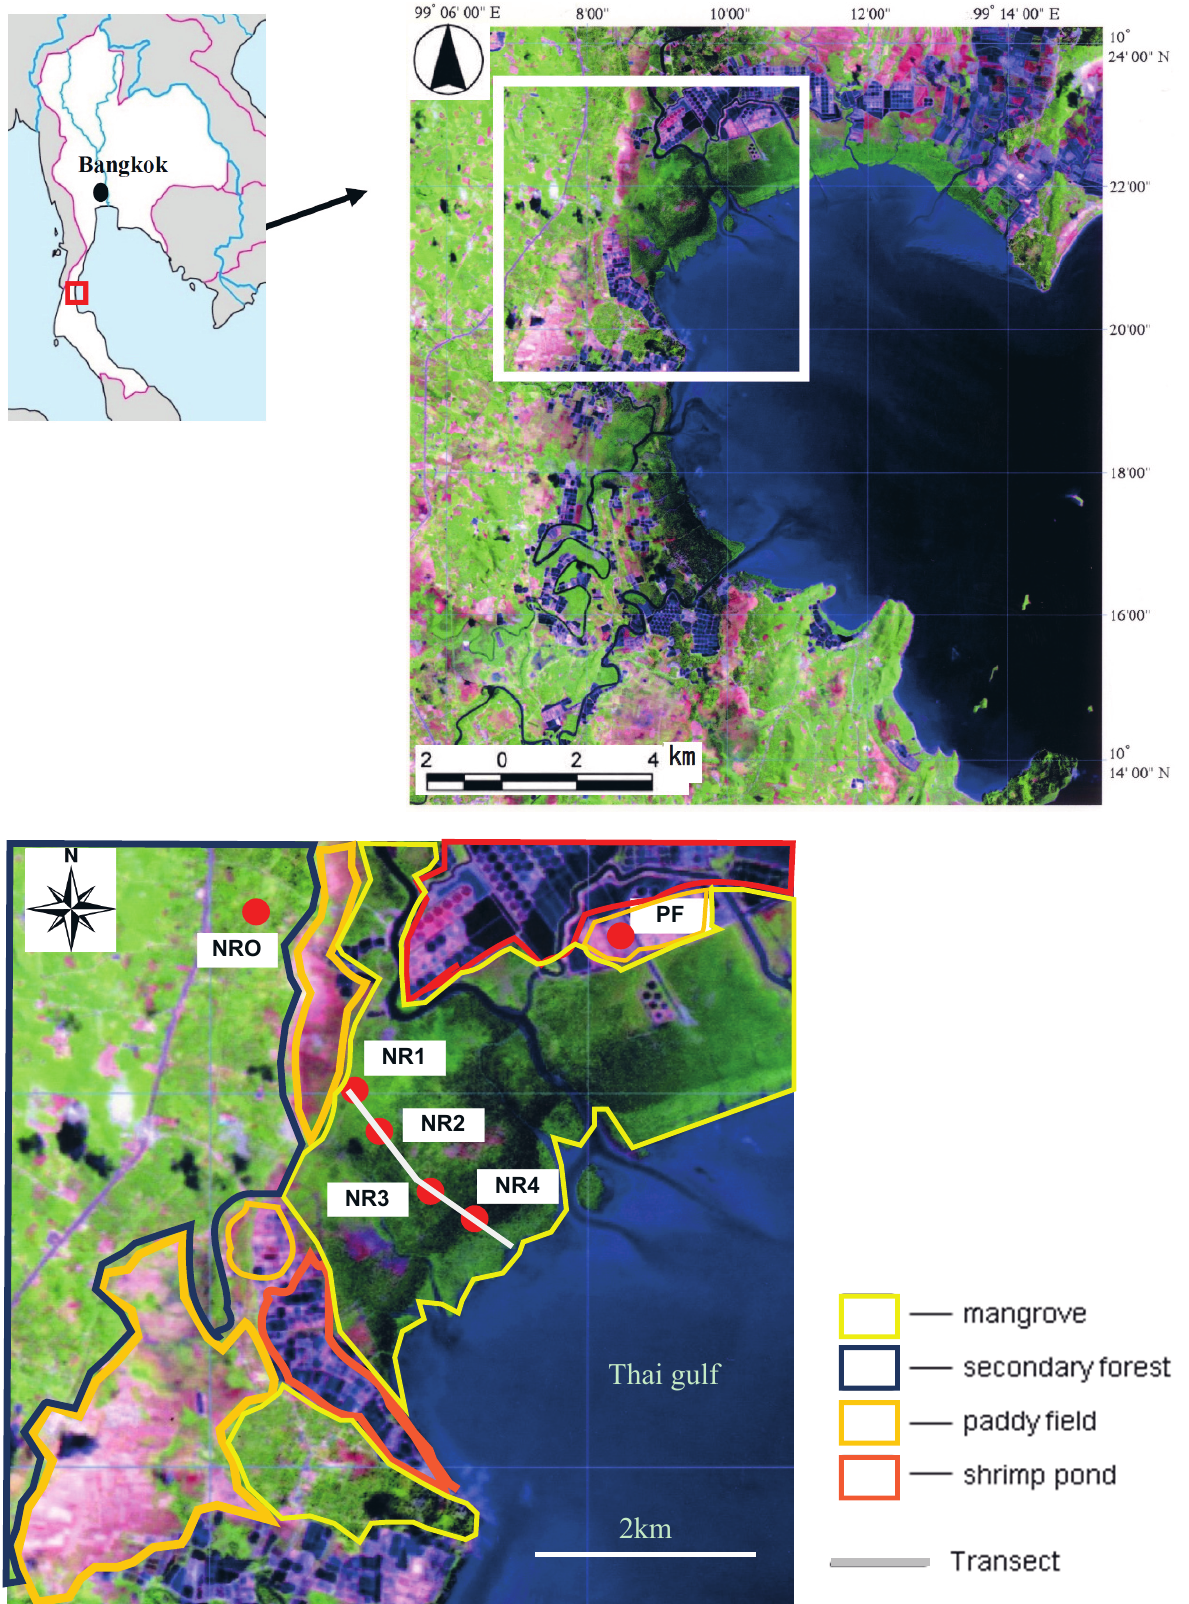
Figure 1. Location of study site is indicated by a white square in Landsat image. The transect was made by crossing different mangrove vegetation types. Boring survey was conducted in mangrove ecosystem (NR1–NR4), coconut plantation (NR0), and paddy field (PF).